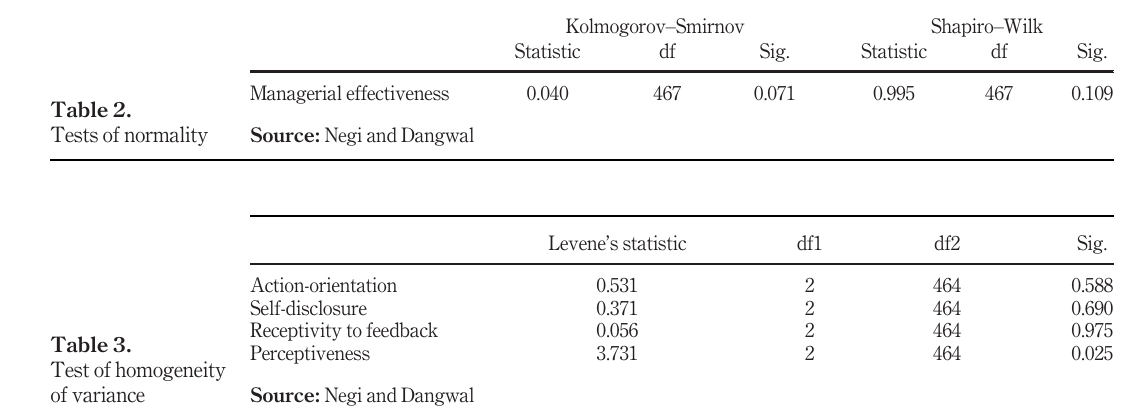
Table 1. Descriptive of managerial effectiveness